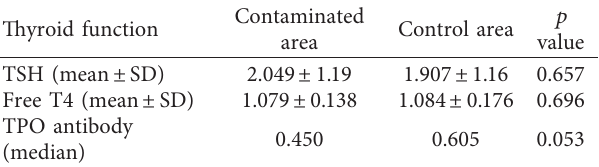
Table 3: Comparison of mean values of TSH, T4, and TPO an- tibodies measured among the study participants based on the study area.